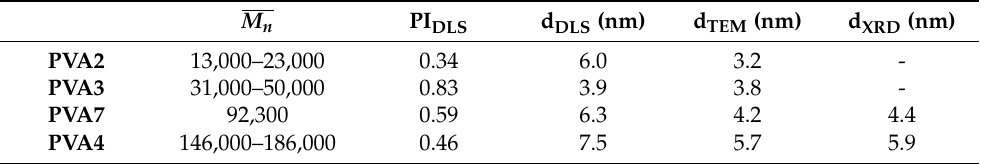
Table 4. Comparison between poly-dispersity index (PI), dynamic light scattering (DLS), X-ray diffraction (XRD), and transmission electron microscopy (TEM) diameter of gold nanoparticles synthesized using PVA with different molecular